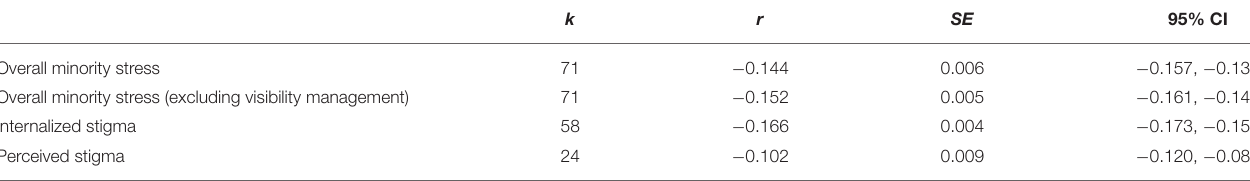
TABLE 1 | Results of “bare bones” second-order meta-analysis of associations between minority stress and relationship functioning. k r